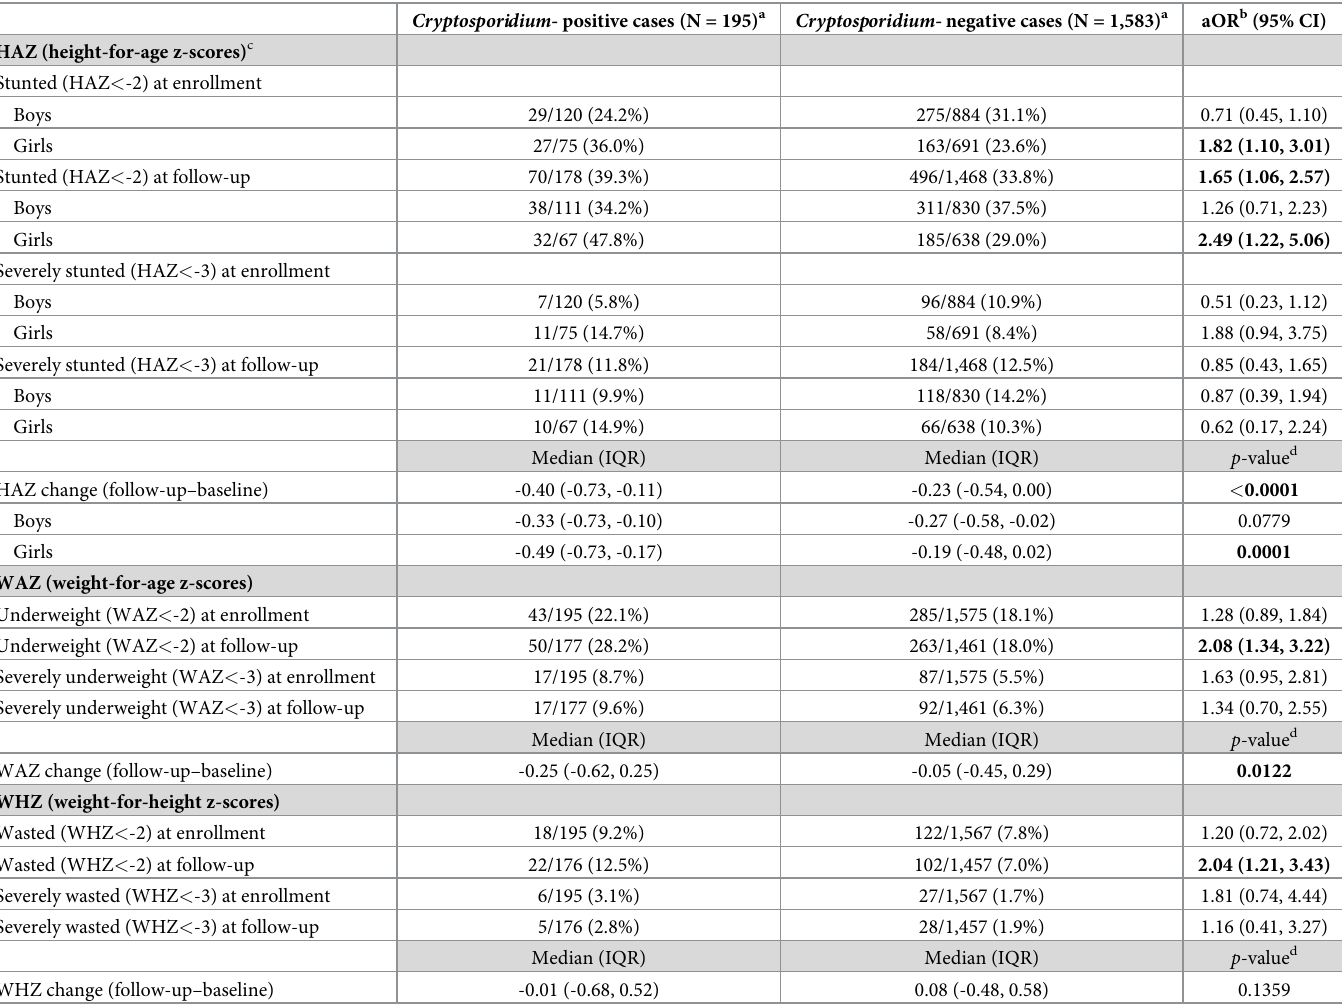
Table 3. Anthropometric indicators of malnutrition for GEMS-Kenya cases (N = 1,778), by Cryptosporidium status, western Kenya, 2008–2012. Cryptosporidium- positive cases (N = 195)